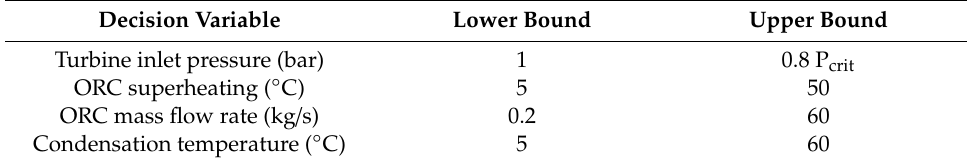
Table 1. ORC design model: decision variables in the optimization procedure.